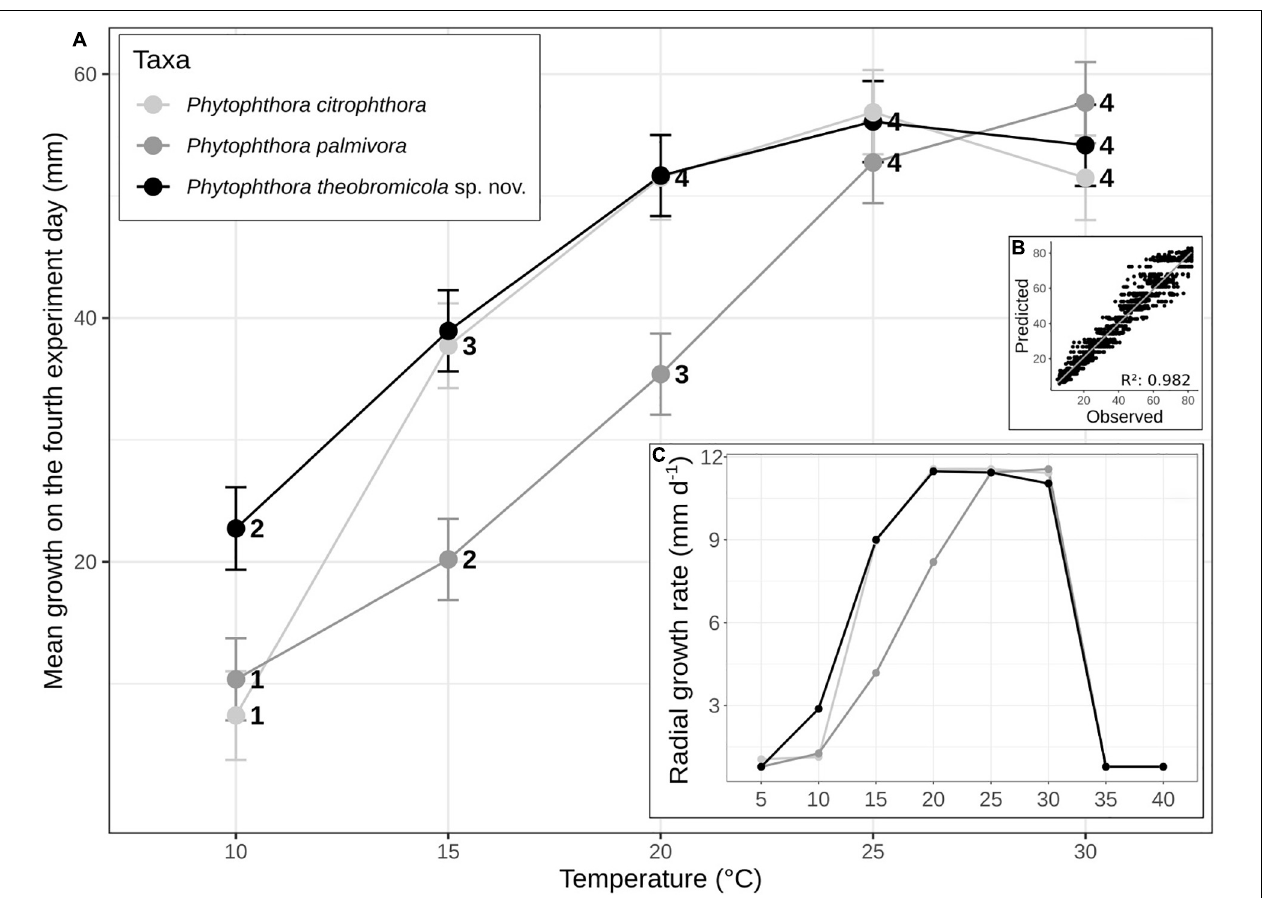
FIGURE 4 | Mean ( ± SE) of growth rates of Phytophthora species on carrot-agar (CA) at different temperature intervals. The statistical significance (95% confidence interval) of paired comparisons, performed between linear mixed-effects model estimates, is indicated by numbers above the horizontal axis (A) . Growth rates of Phytophthora species vs. predicted rates using the linear mixed-effect model (B) . Mean radial growth rates of Phytophthora citrophthora ( n = 1), Phytophthora palmivora ( n = 4), and Phytophthora theobromicola ( n = 4) isolates on CA at eight different temperatures (C) .